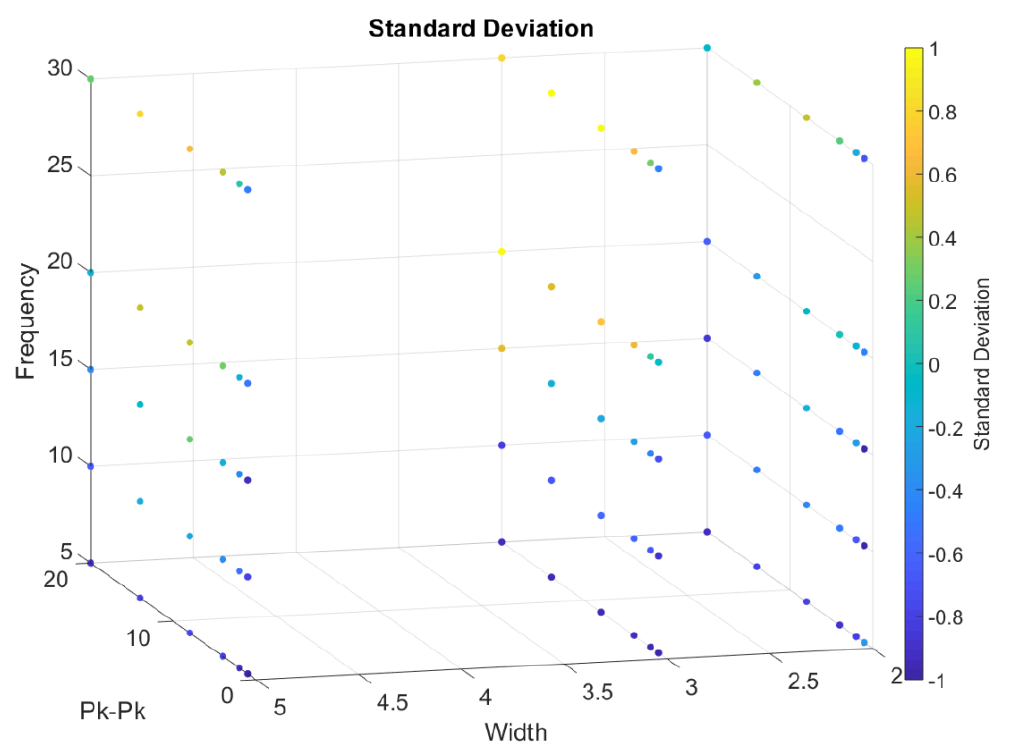
Figure 18. A 3D scatter plot for Standard Deviation.